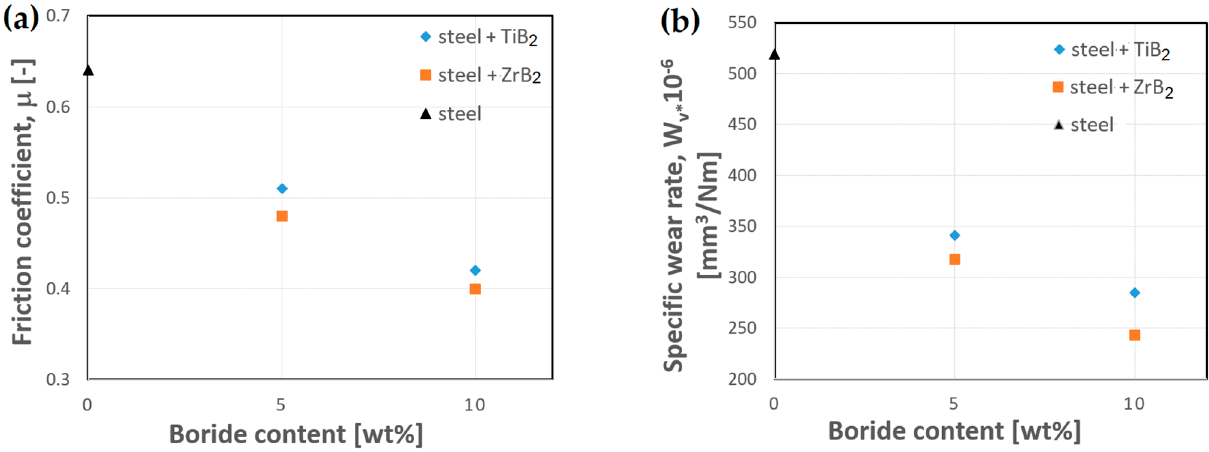
Figure 11. Variations in ( a ) the coefficient of friction and ( b ) the specific wear rate as a function of the content of ceramic compositions.